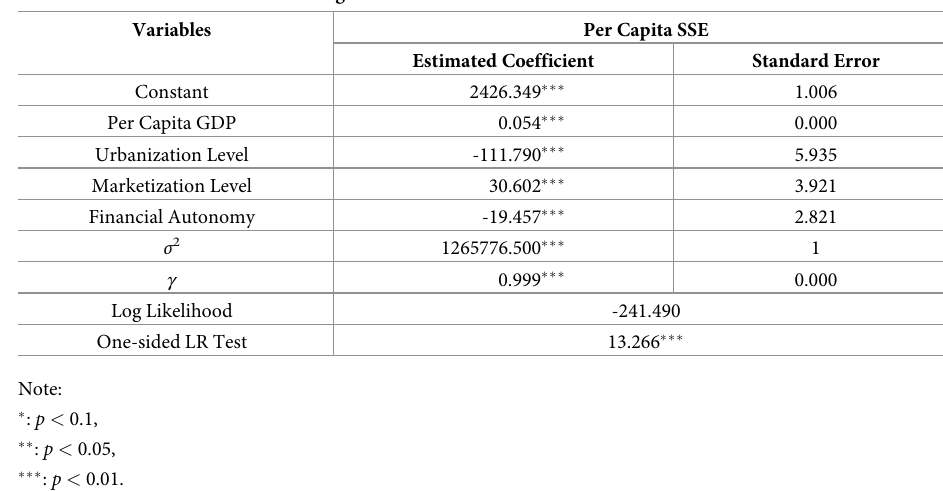
Table 4. Results of the SFA model: Stage